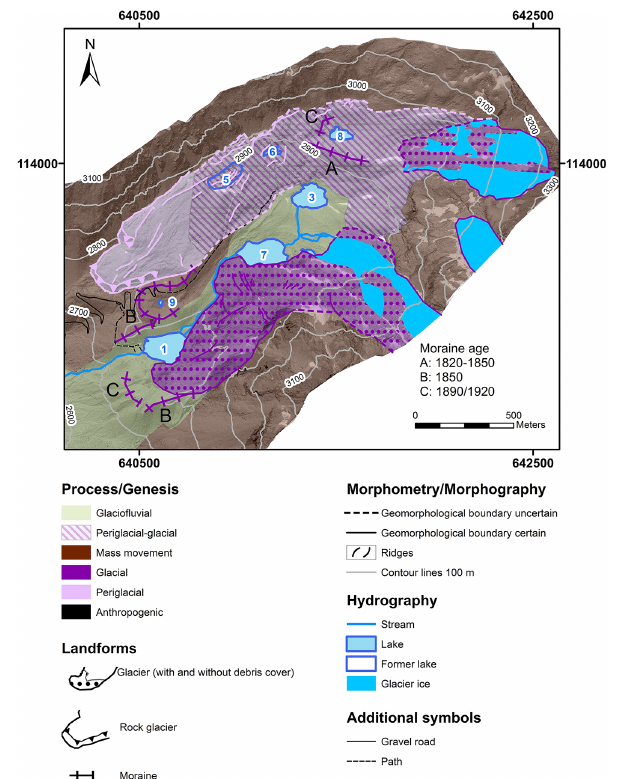
Figure 4. Geomorphological map of the Gruben site. The moraine ages are taken from Whalley (1979) (age A) and Haeberli et al. (1979) (ages B and C). The numbering of lakes 1 to 9 follows the historical sequence of lake formation and denomination; lakes 2 and 4 are not present anymore. The mapping is conducted on the orthophoto and DTM as of 2016 (© swisstopo). Axes are labelled with Swiss coordinates (in metres; CH